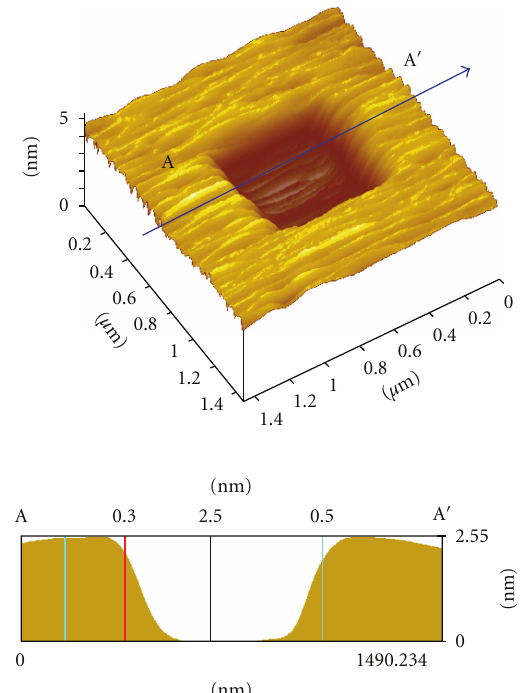
Figure 16: Profile and cross-sectional images of 4-nm-period (BN/C)n topography at 1000 nN load and vibration amplitude of